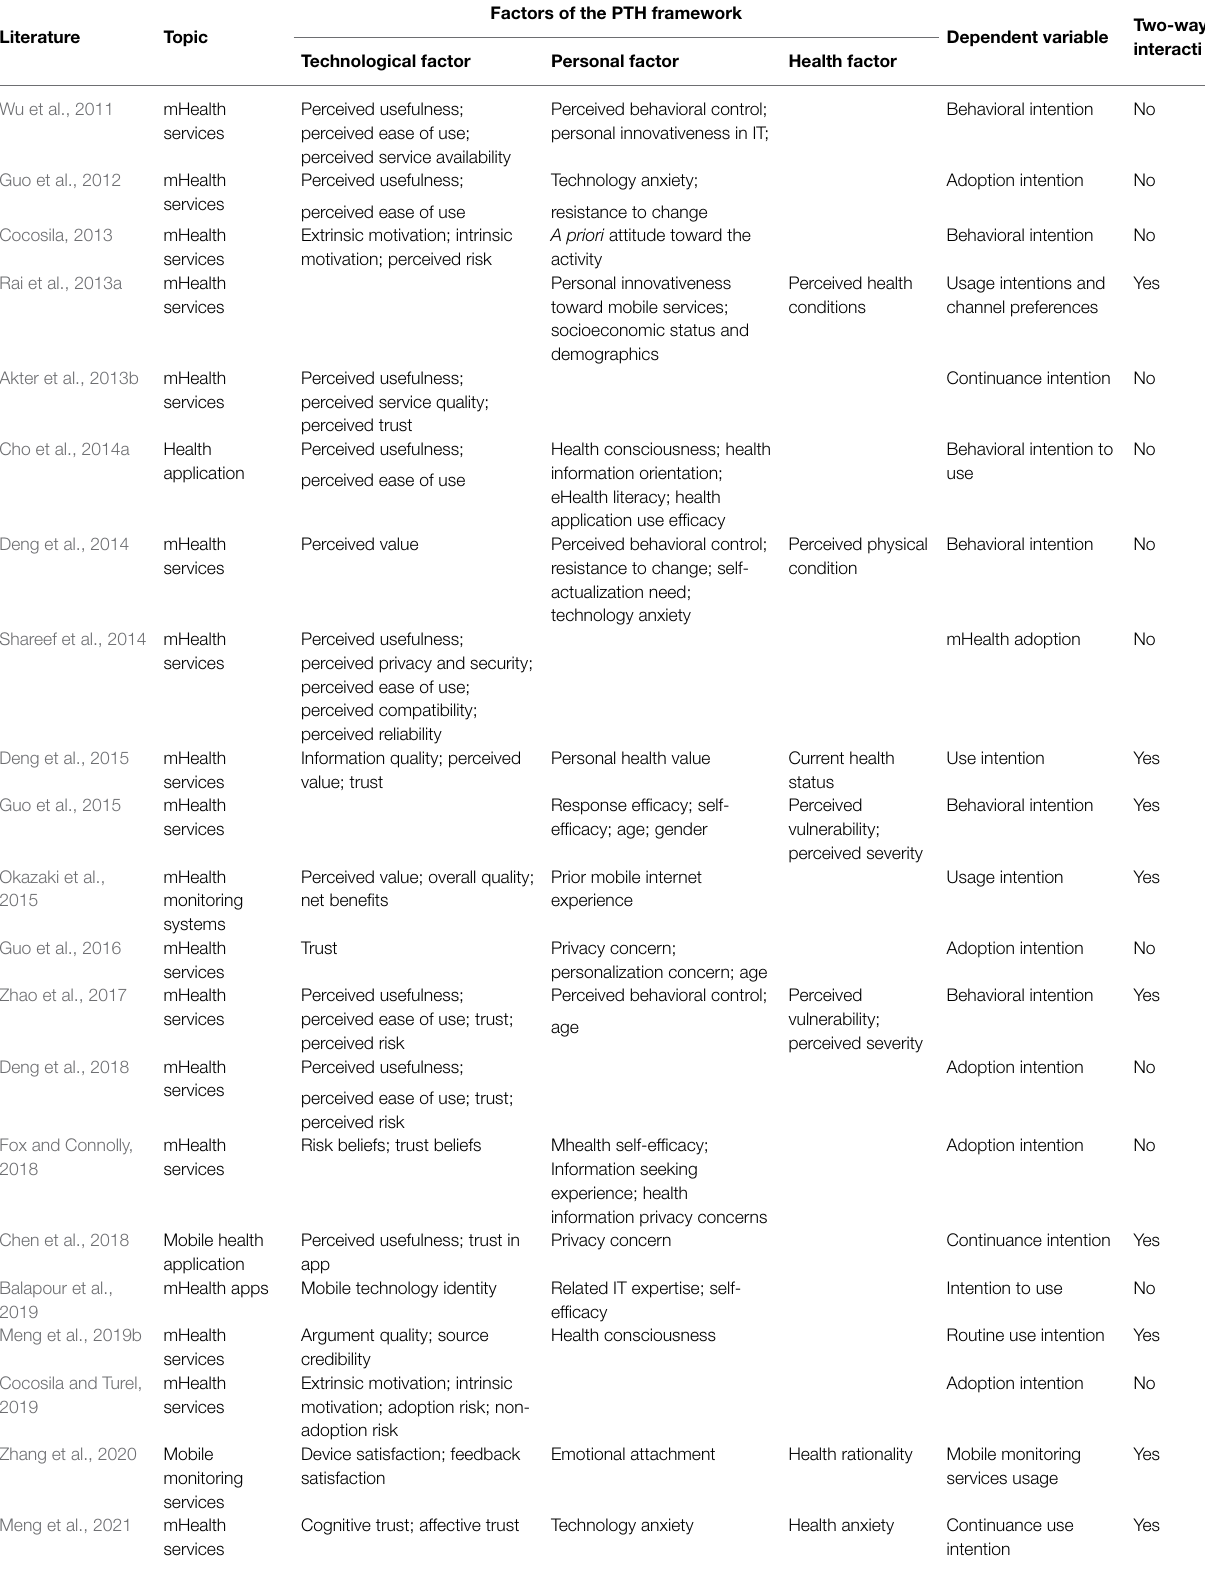
TABLE 1 | Factors of the PTH framework in prior studies.